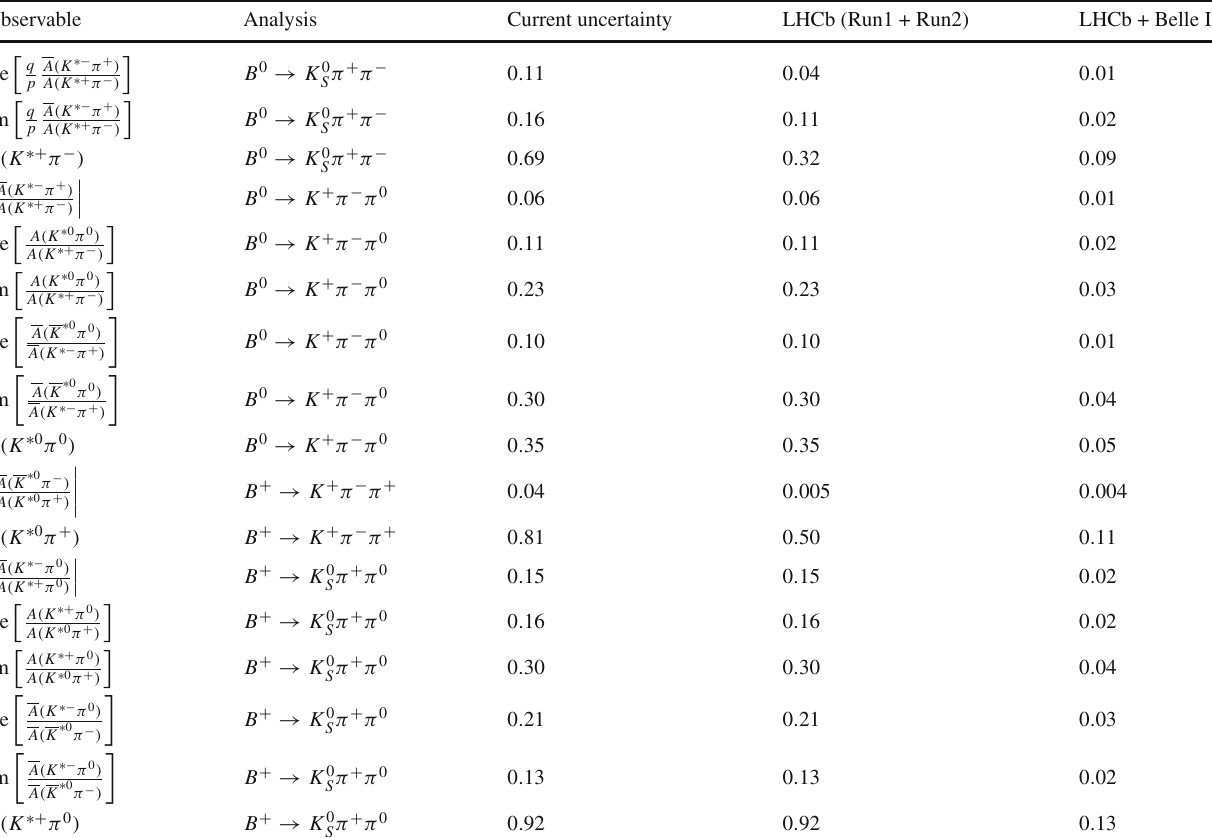
Table 12 Prospective scenarios for statistical uncertainties on the B → K (cid:7) π observables. The extrapolations are based on the current statistical uncertainties from BaBar results. The uncertainties on the branching fractions are given in units of 10 −